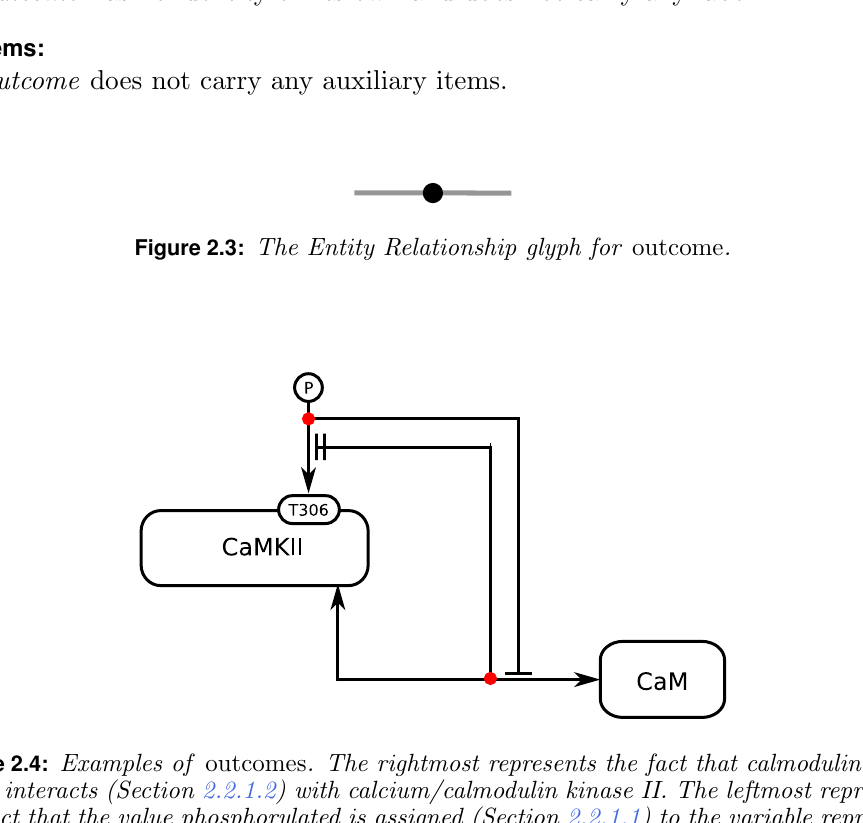
Figure 2.4: Examples of outcomes . The rightmost represents the fact that calmodulin effec- tively interacts (Section 2.2.1.2) with calcium/calmodulin kinase II. The leftmost